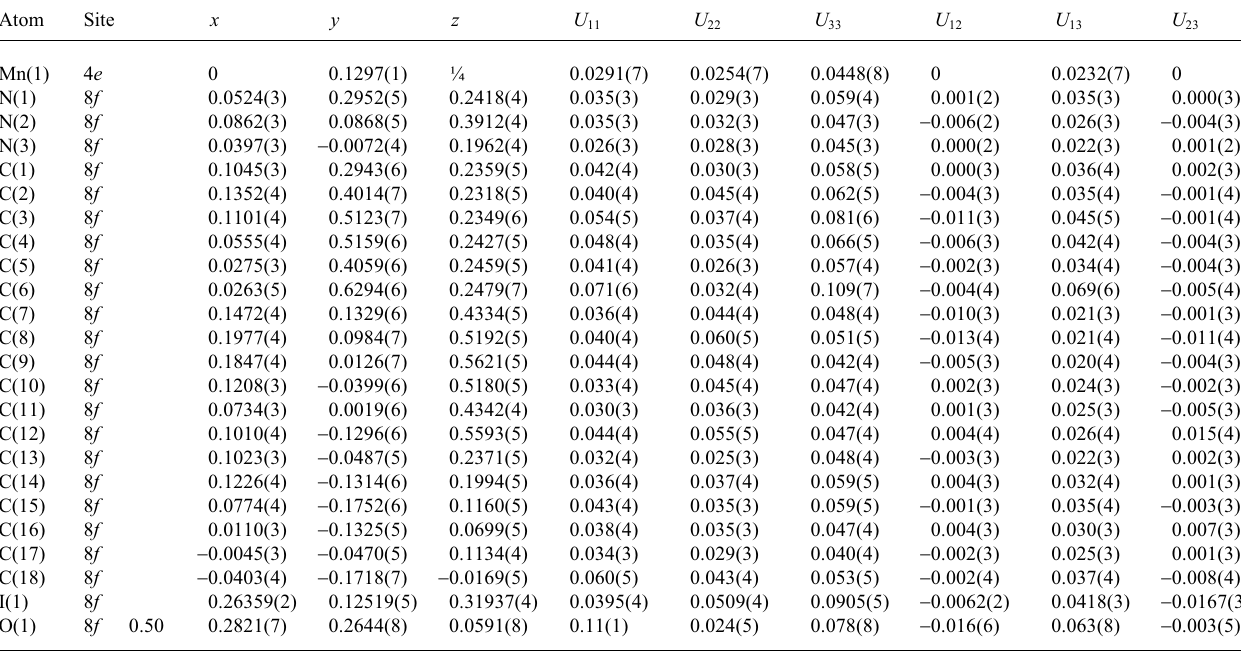
Table 3. Atomic coordinates and displacement parameters (in Å 2 ).